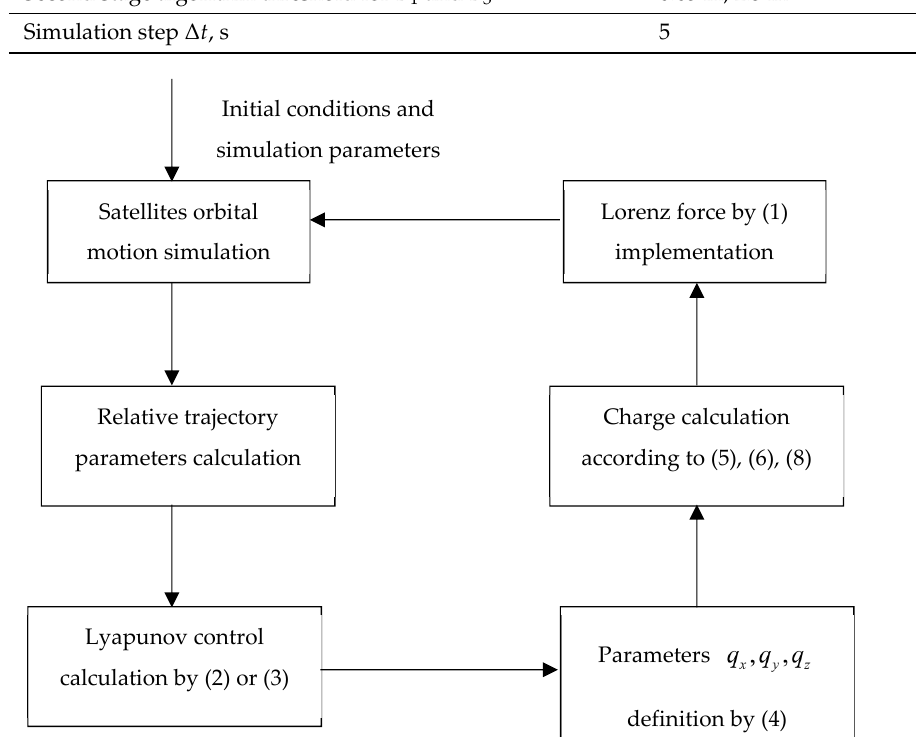
Figure 3. Relative trajectories of the two satellites’ free relative motion.